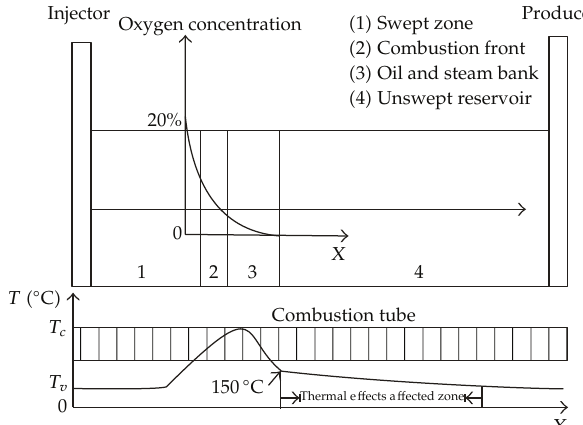
Figure 1: Compared diagrams of conceptual air injection process and combustion tube